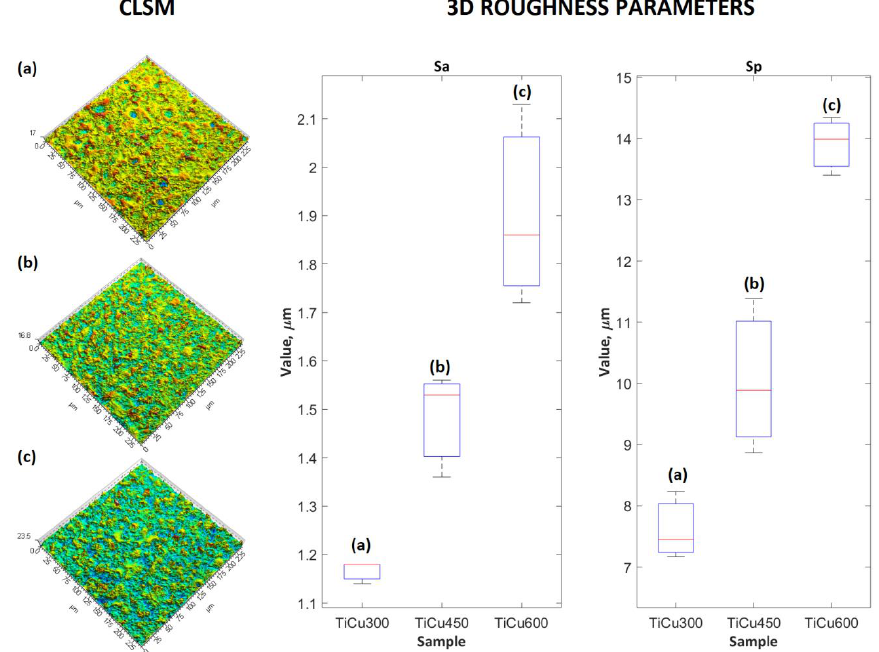
Figure 2. CLSM images of PEO coatings (left side) and corresponding to 3D surface roughness parameters (right side) of the three coatings: TiCu300 ( a ), TiCu450 ( b ), and TiCu600 ( c ).